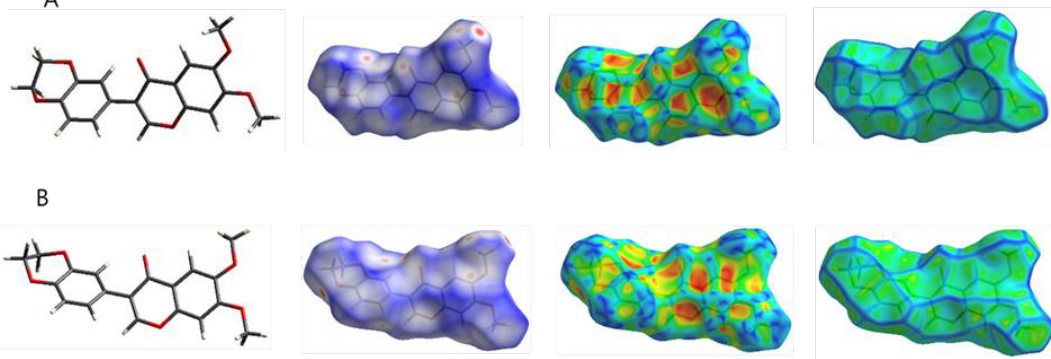
Figure 6. ( A ) Hirshfeld surfaces of molecule 5I mapped with d norm , shape index and curvedness. ( B ) Hirshfeld surfaces of molecule 5II mapped with d norm , shape index and curvedness.